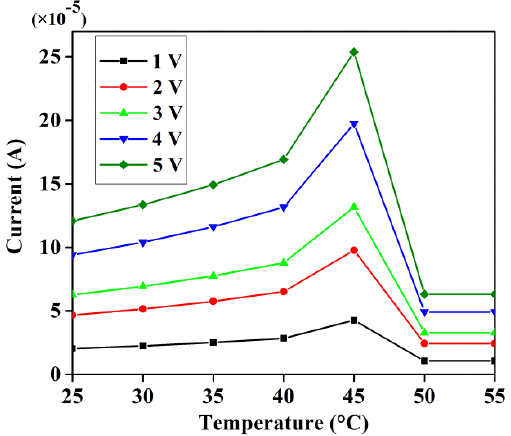
Figure 3. Temperature dependent current of GDG structure at different voltages in the absence of magnetic